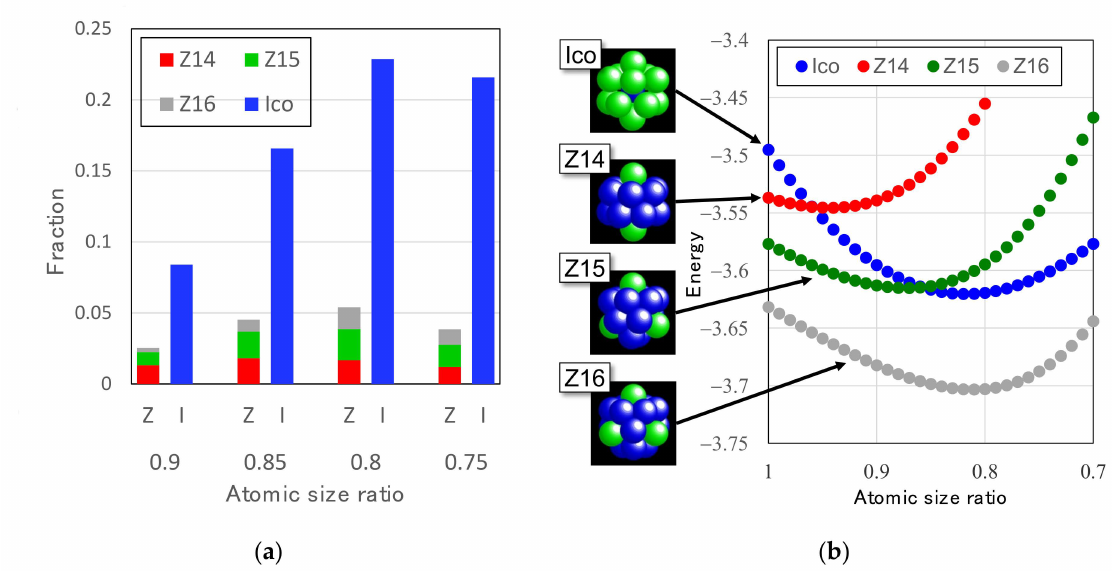
Figure 5. ( a ) Atomic size dependence of the population of the fraction of I- and Z-clusters in quenched glassy A 50 B 50 phases formed by slow-cooling processes. ( b ) Atomic size dependence of the atomic energy of I- and Z-clusters. Atomic configuration of each cluster is shown in the insets, where the green and blue sphere denote the A and B atoms,